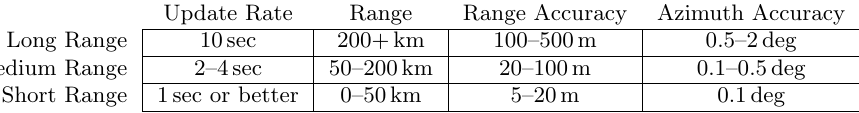
Table 1: An example of typical 2D surveillance radar specifications